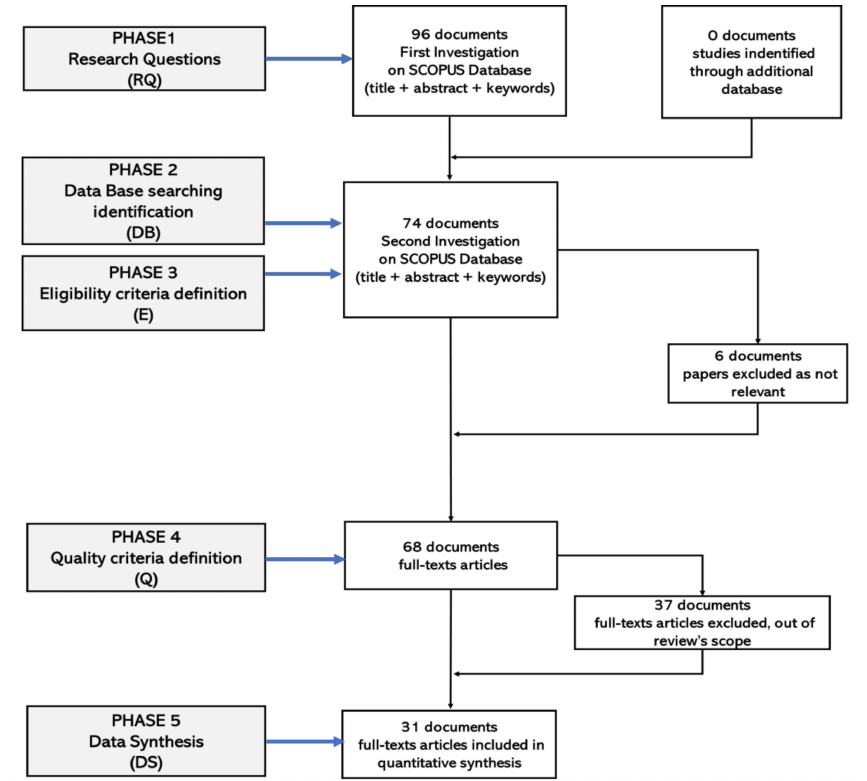
Figure 3. Flow diagram for the selection of documents based on Preferred Reporting Items for Systematic Reviews and Meta-Analyses